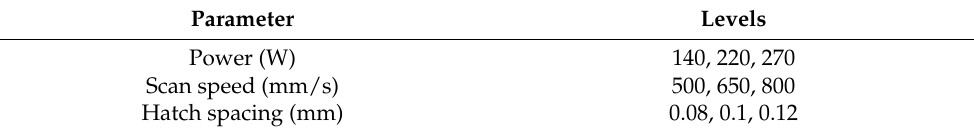
Table 3. Process parameters for LPBF of